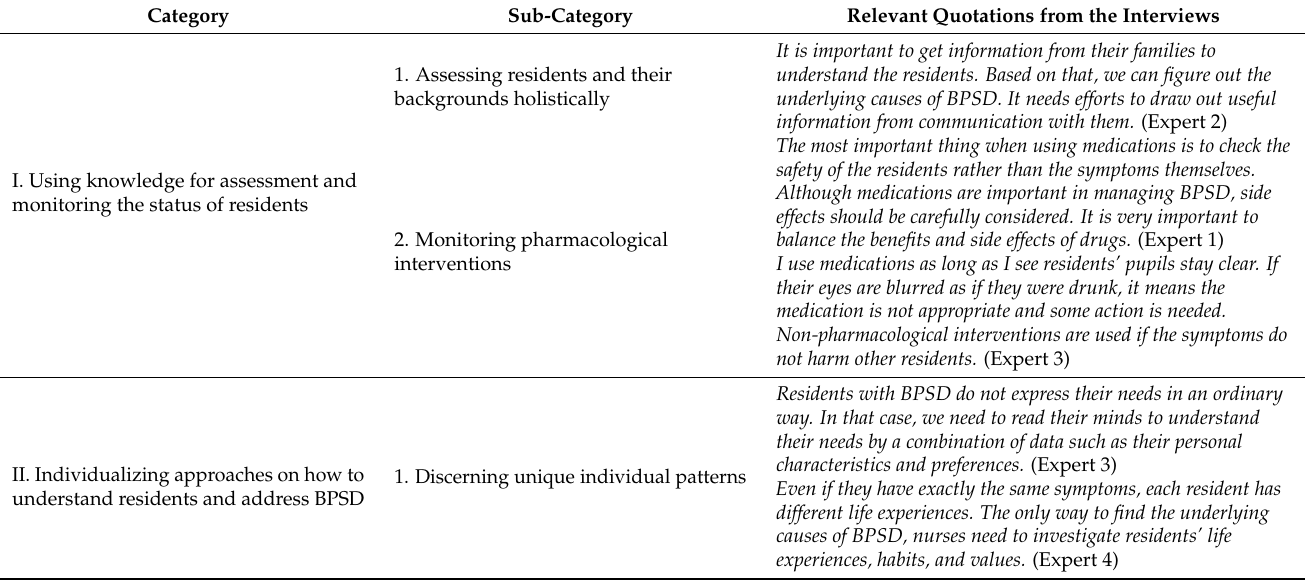
Table 2. Categories of the practical needs of LTCF education for BPSD care competence with relevant statements from the in-depth